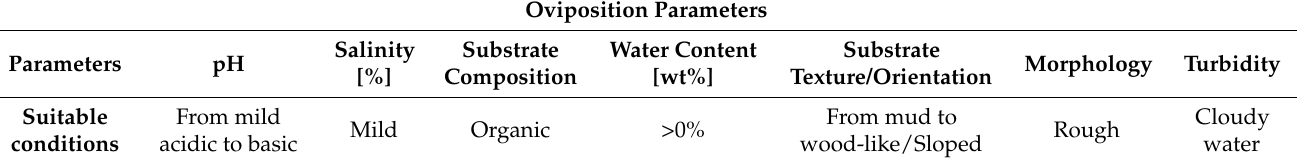
Table 1. A panel of possible oviposition influencing parameters and possible suitable conditions reported in